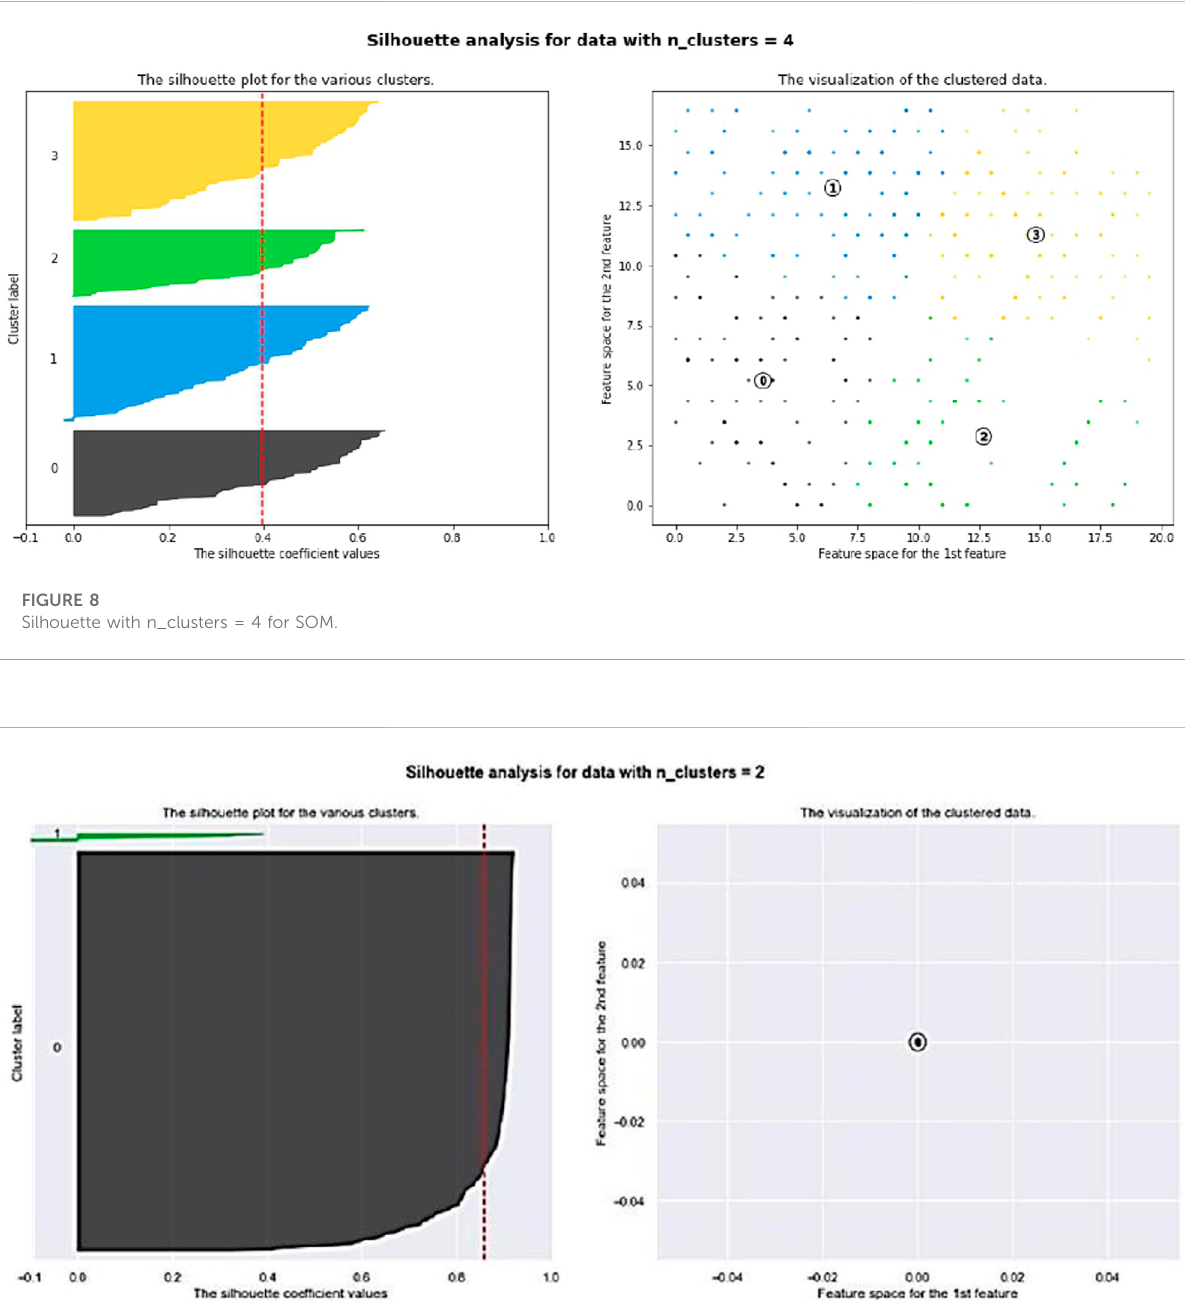
FIGURE 9 Silhouette with n_clusters = 2 for